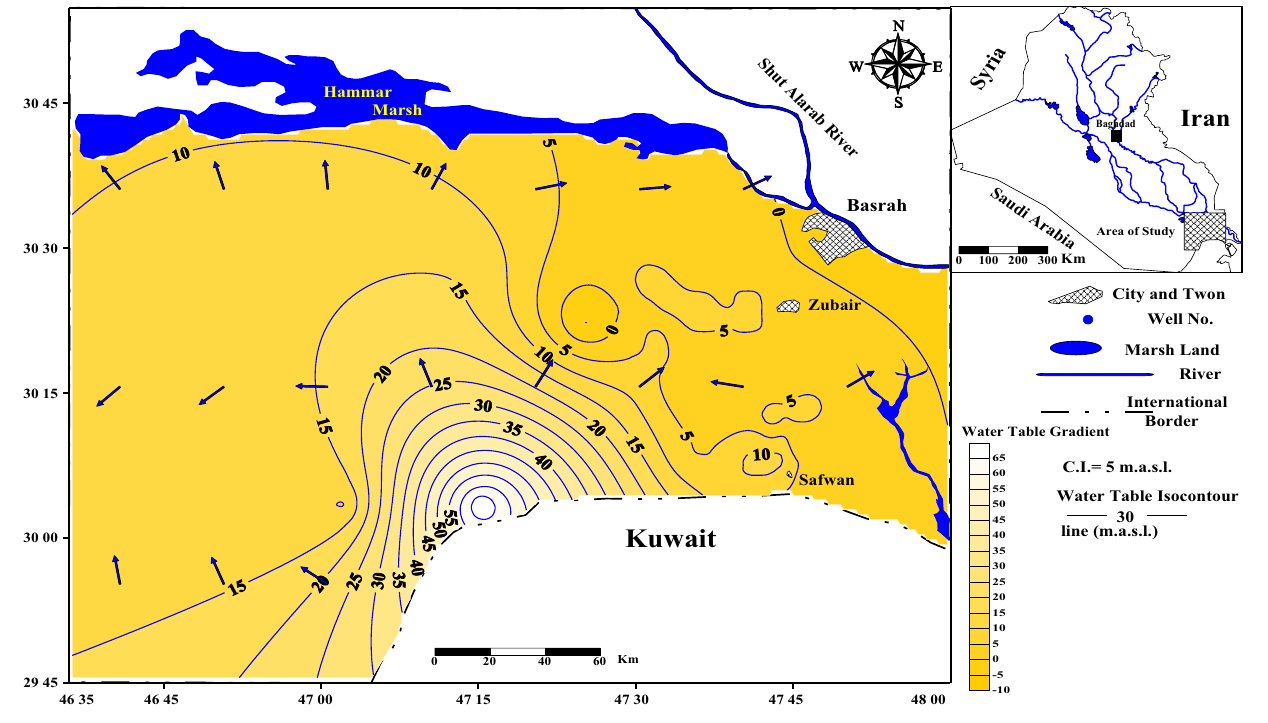
Fig. 7 Groundwater flow map of the